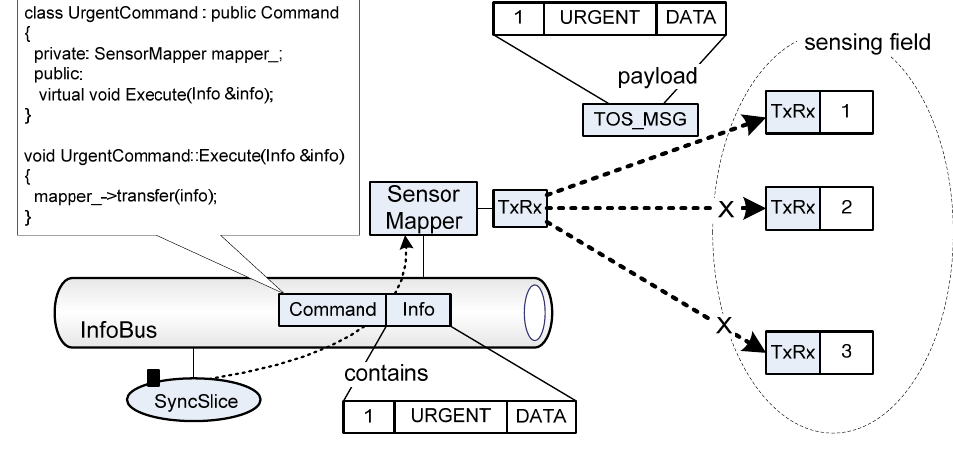
Figure 8. Processing of a URGENT request which accesses to a specific sensor